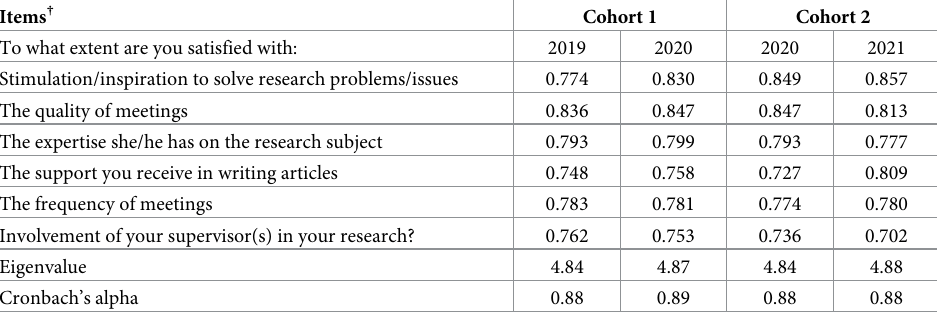
Table 1. Eigenvalue and Cronbach’s alpha for component of satisfaction with supervisor support by year of PhD survey. Items † Cohort 1 Cohort